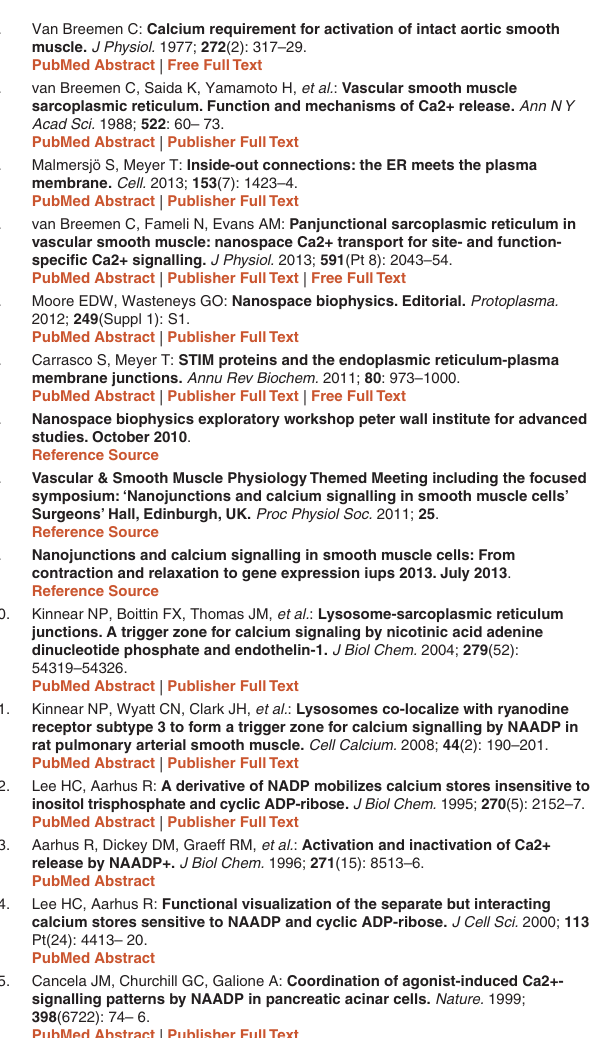
figshare: L-SR nanojunction study data, doi: